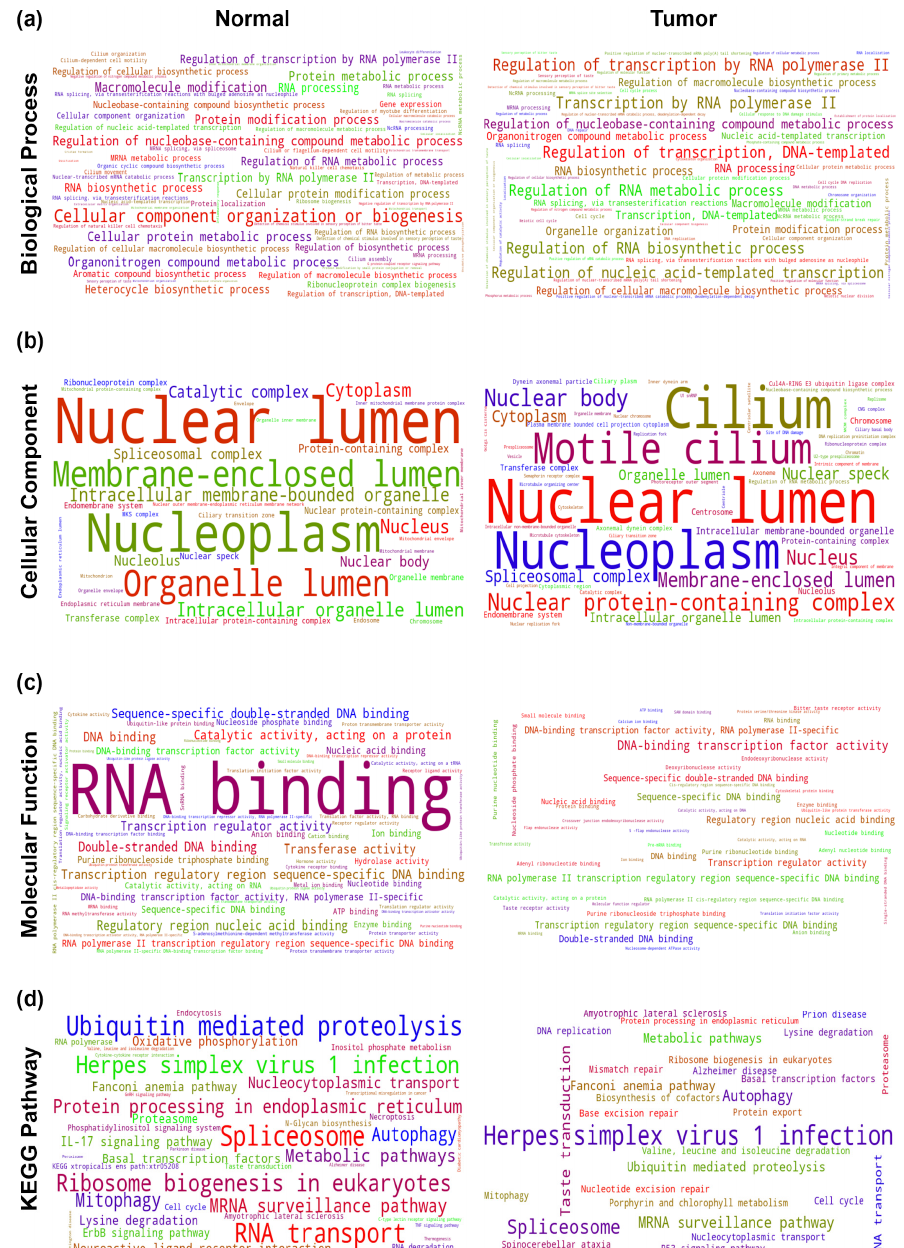
Figure 11. Gene ontology (GO) and KEGG pathway analyses of genes co-expressed with THAP9-AS1 in normal vs. tumor samples. The enrichment test was performed for normal vs. tumor samples (for each cancer) using ShinyGO for the top 10 enriched terms, with the significance cutoff for adjusted p -values being set at 0.05. The font sizes in the word cloud are proportional to their frequency after the enrichment rates were merged for all cancers (left side for normal samples and right side for tumor samples). Word clouds of enriched GO terms in ( a ) the biological process category, ( b ) cellular component category, ( c ) molecular functions category, and ( d ) KEGG pathways.